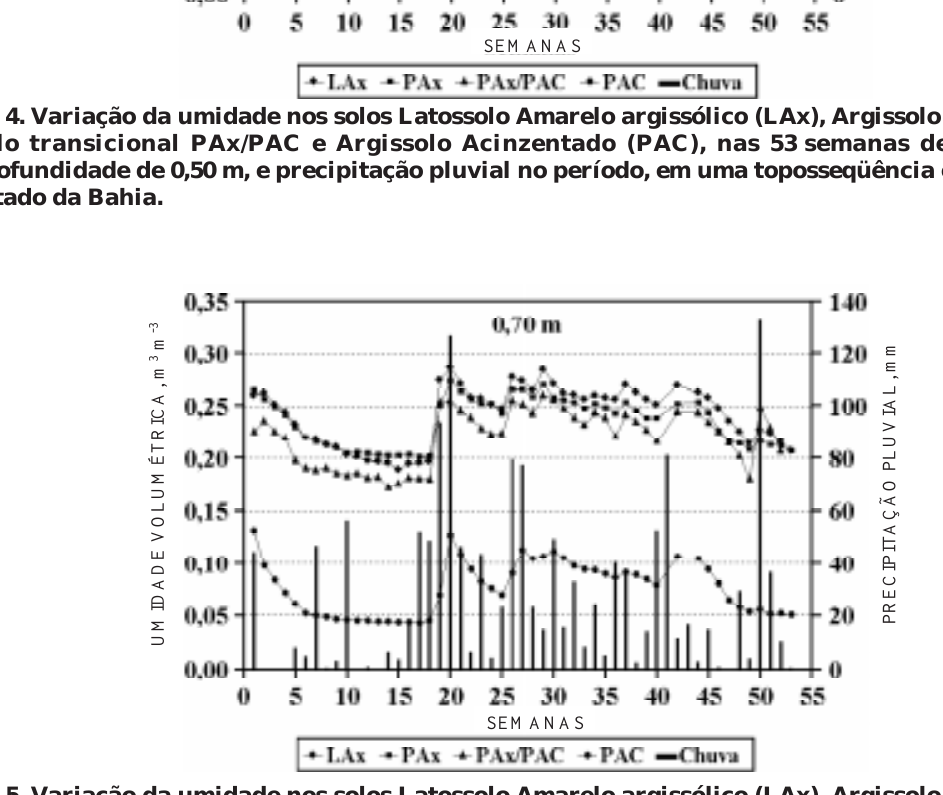
Figura 5. Variação da umidade nos solos Latossolo Amarelo argissólico (LAx), Argissolo Amarelo (PAx), solo transicional PAx/PAC e Argissolo Acinzentado (PAC), nas 53 semanas de avaliação, na profundidade de 0,70 m, e precipitação pluvial no período, em uma toposseqüência em tabuleiro do estado da Bahia.